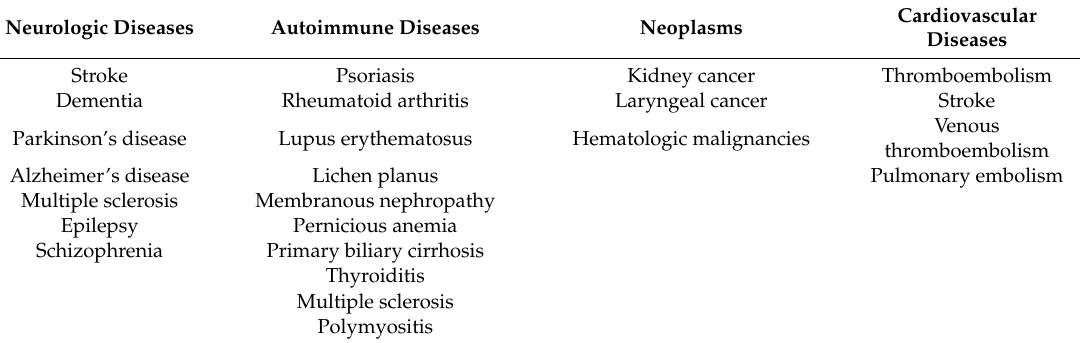
Table 2. Bullous pemphigoid